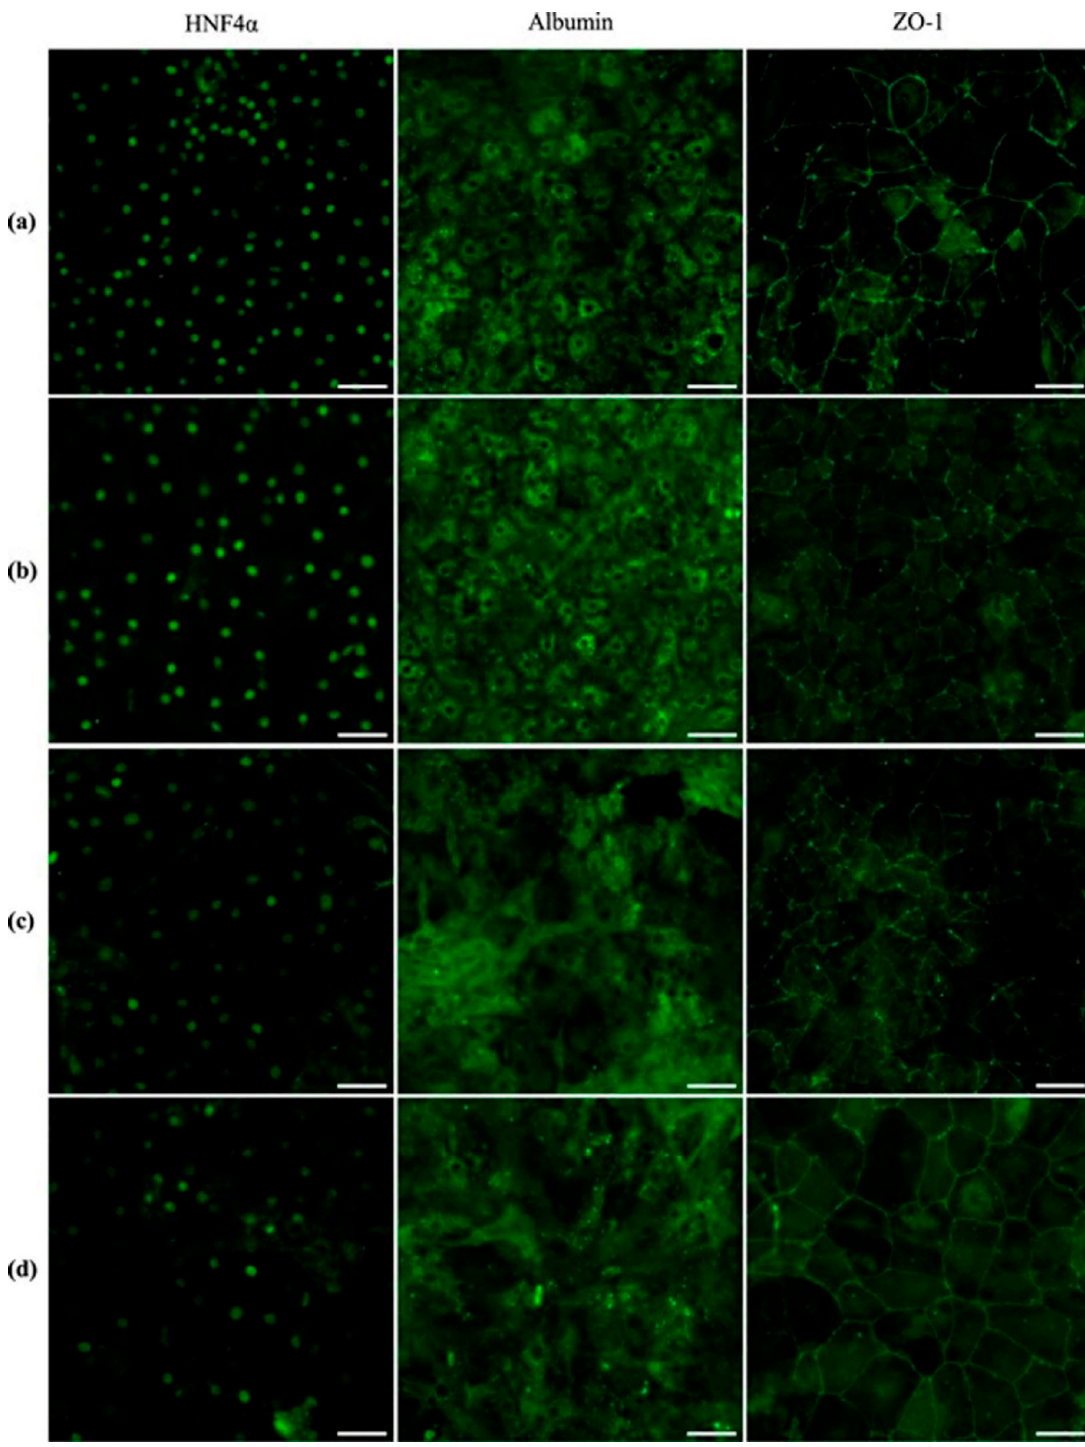
Figure 7. Fluorescence images of printed human-induced pluripotent stem cells (hiPSC)-derived hepatocytes showing hepatocyte marker expression in green: ( a , b ) human embryonic stem cells (hESC)-derived hepatocyte-like cells (HLCs) (RC-10): ( a ) Non-printed control; ( b ) printed results; ( c , d ) hiPSC-derived HLCs (RCi-22); ( c ) non-printed control; ( d ) printed results (scale bars 50 µ m) [81].